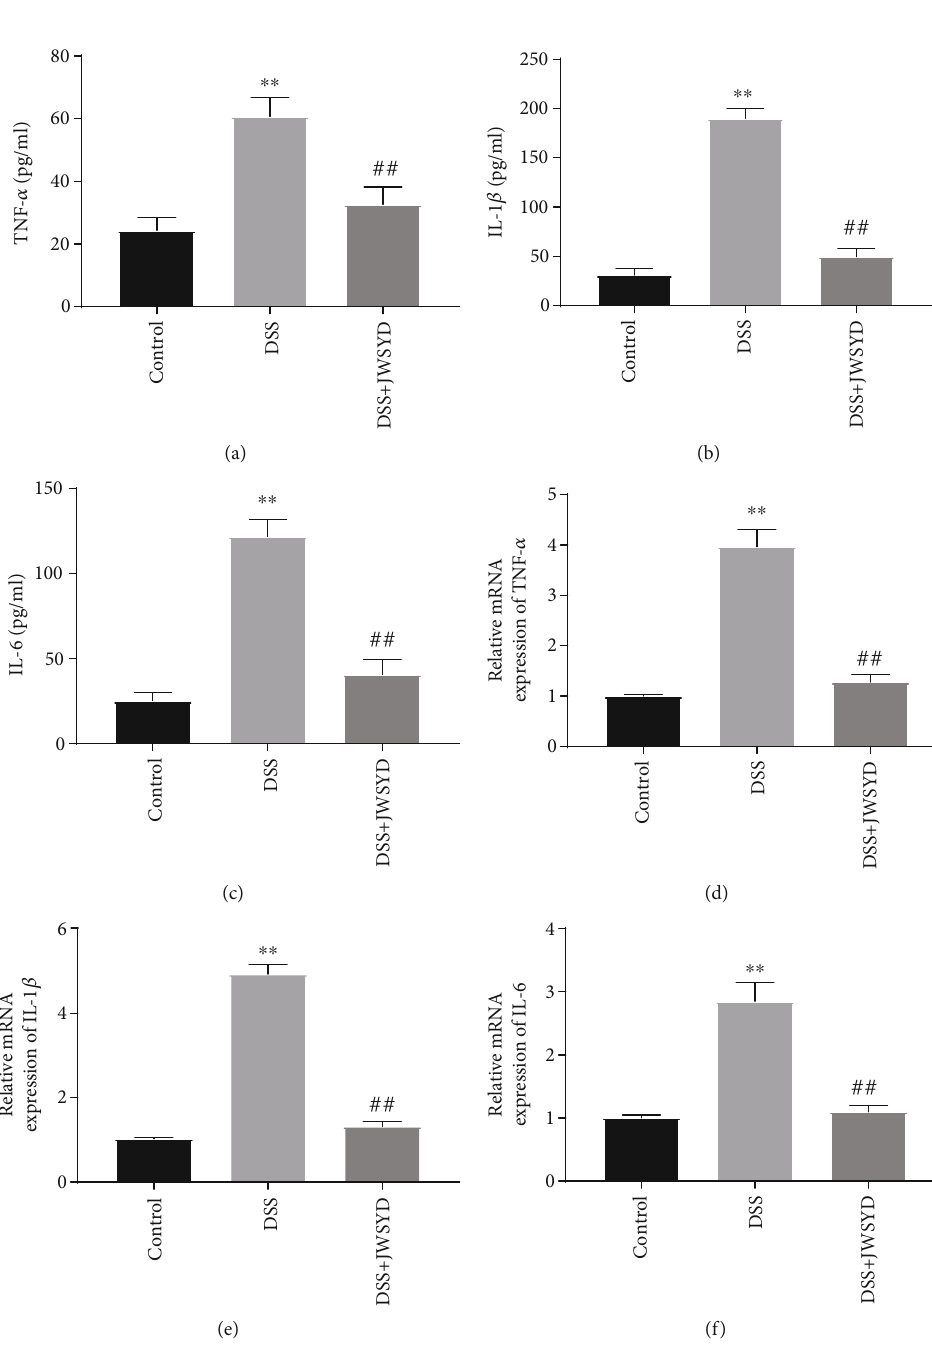
Figure 2: Jiaweishaoyao decoction (JWSYD) reduced the levels of in fl ammatory cytokines in DSS-induced ulcerative colitis (UC). (a – c) The levels of TNF- α , IL-1 β , and IL-6 in serum of mice were detected by ELISA. (d – f) The mRNA levels of TNF- α , IL-1 β , and IL-6 in colon tissues of mice were detected by qRT-PCR. ∗∗ P < 0 : 01 compared with the control group; ## P < 0 : 01 compared with the DSS